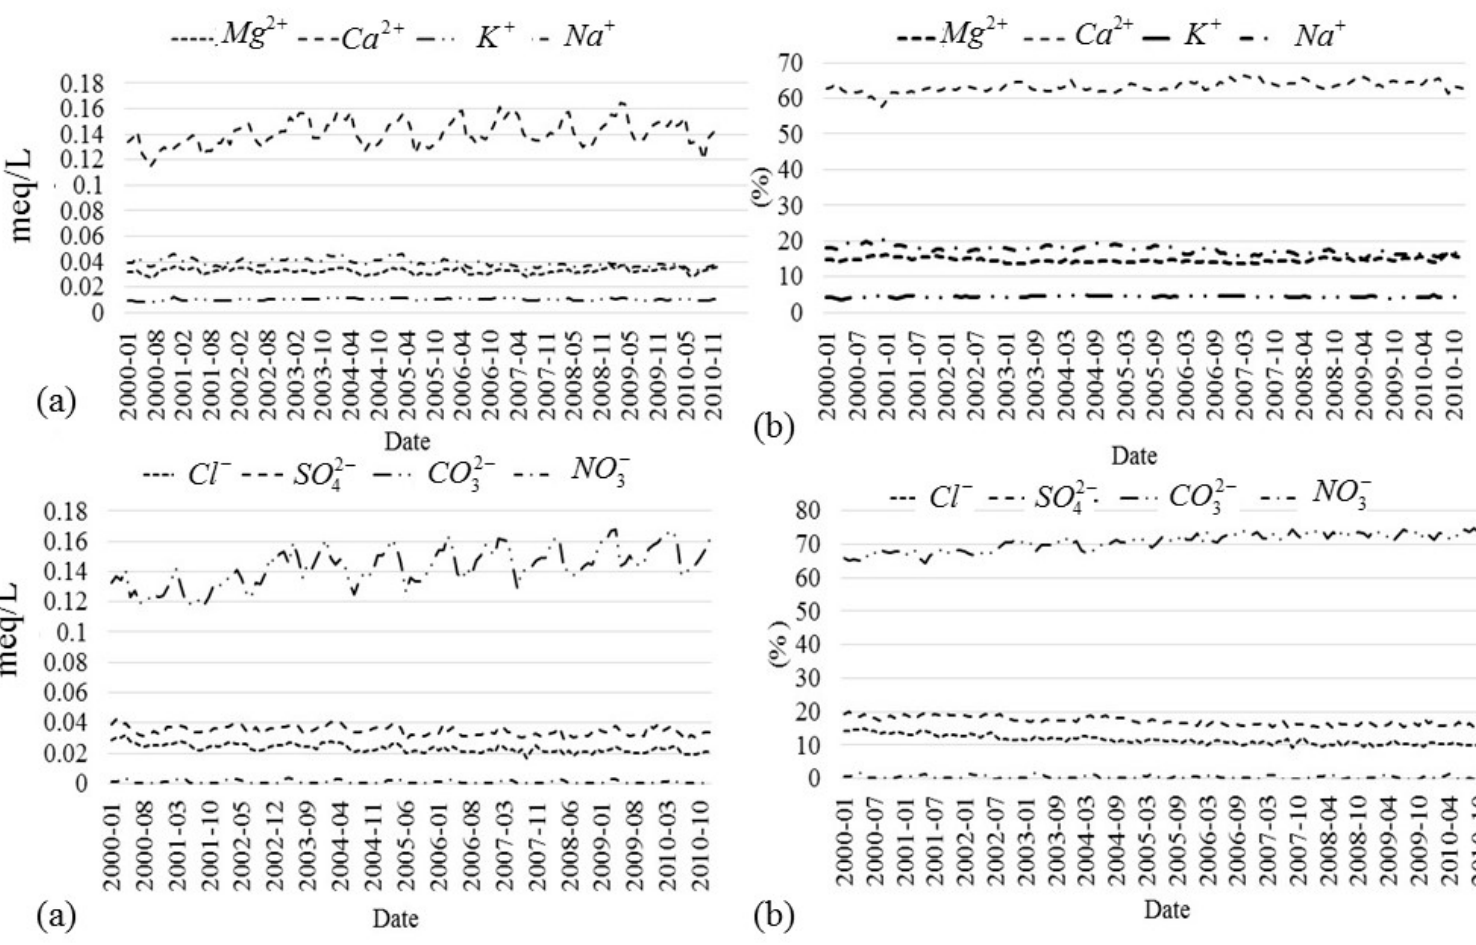
Figure 2. Concentrations of MI at Slagnäs Station in Skellefte älv. ( a ) concentration of MI in equivalent per liter and ( b ) concentration of MI as a percentage in relation to the sum of total positive ions, in case of positive ion, or sum of total negative ions, in case of negative ion (2000–2010) [22].